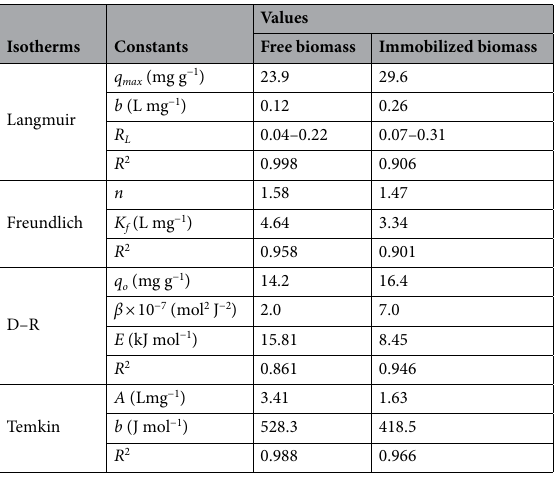
Table 2. Isotherm parameters for Cd 2+ biosorption with the free and immobilized T. ornata biomasses.